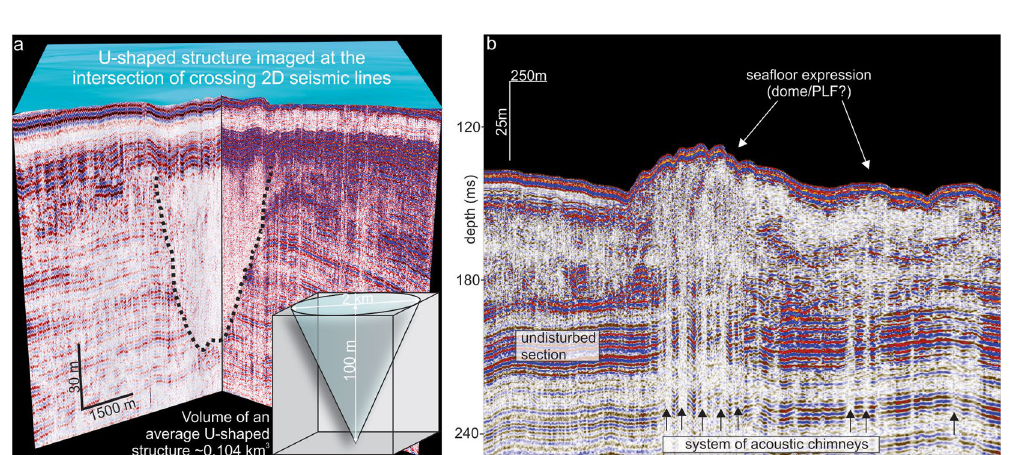
Figure 3. ( a ) Single U-shaped structure in the intersection of two high-resolution seismic lines. Inset shows volumetric approximation for an average-size U-shaped structure, providing constrains for the total thermokarst pool volume within the study area. See location in Fig. 1. ( b ) Fragment of a high-resolution seismic line, showing acoustic chimneys – evidence for shallow fluid flow and gas migration in the South Kara Sea and related seafloor mounds above the chimney